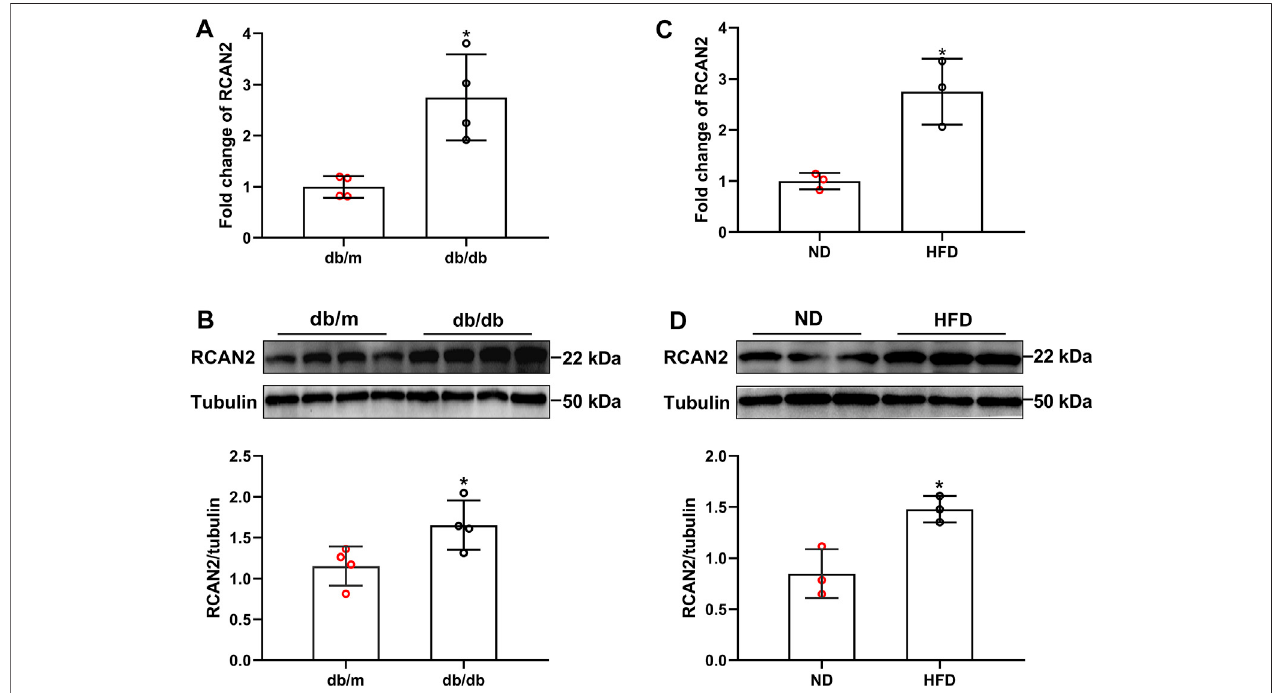
FIGURE1| RCAN2expressionwasupregulatedinliversofdb/dbmiceandHFD-inducedmice.ThemRNA (A) andprotein (B) expressionofRCAN2indb/dbmice vsdb/mmice;ThemRNA (C) andprotein (D) expressionofRCAN2inHFDmicevsNDmice.ND,normaldiet;HFD,high-fatdiet.Thedatawaspresentedasmean±SD. * p < 0.05 vs ND or